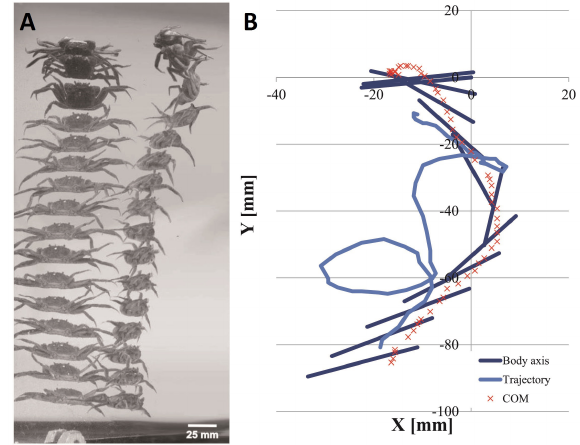
Figure 2. A . Stereotypical turning maneuvers ob- served for E. sinensis after a virtually moment-free start ([9], modified). ∆t = 0.2 s. B . Positions of body axis, right 5th leg and COM for one individual (E. s.). Origin of ordinates on caudal end of carapace at starting point. ∆t = 0.02 s (0.1 s for body axis).